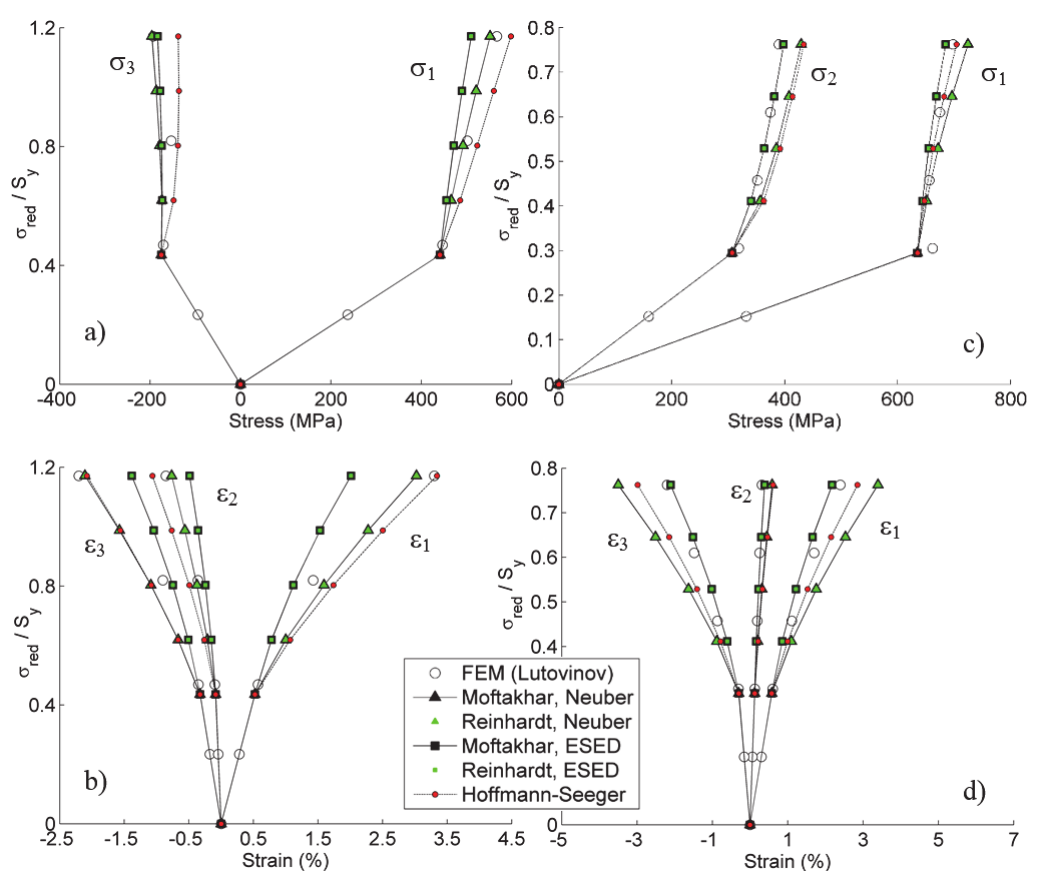
Figure 1: Results of estimations carried out on the round specimen (a, b) and the hollow tube (c, d) [3].  red is equivalent nominal net stress and S y is yield